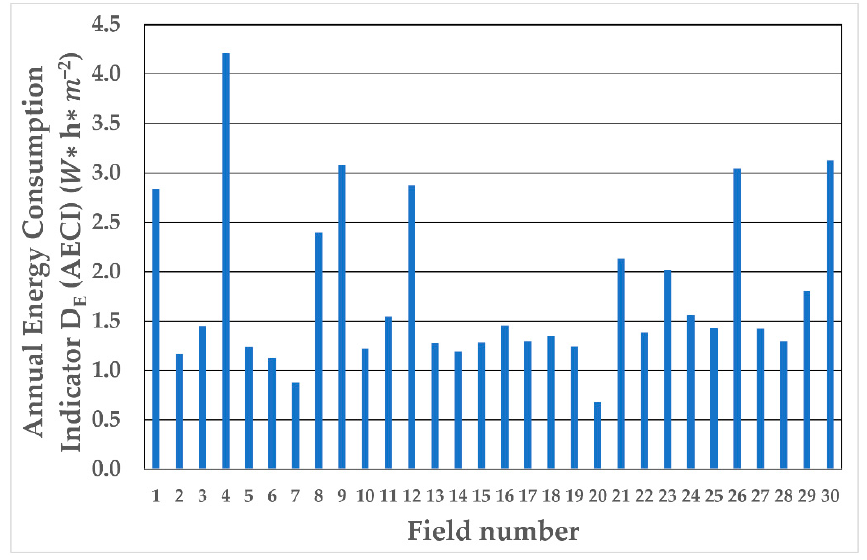
Figure 15. D E (AECI) Annual Energy Consumption Indicator ( W ∗ h ∗ m − 2 ) in calculation fields.